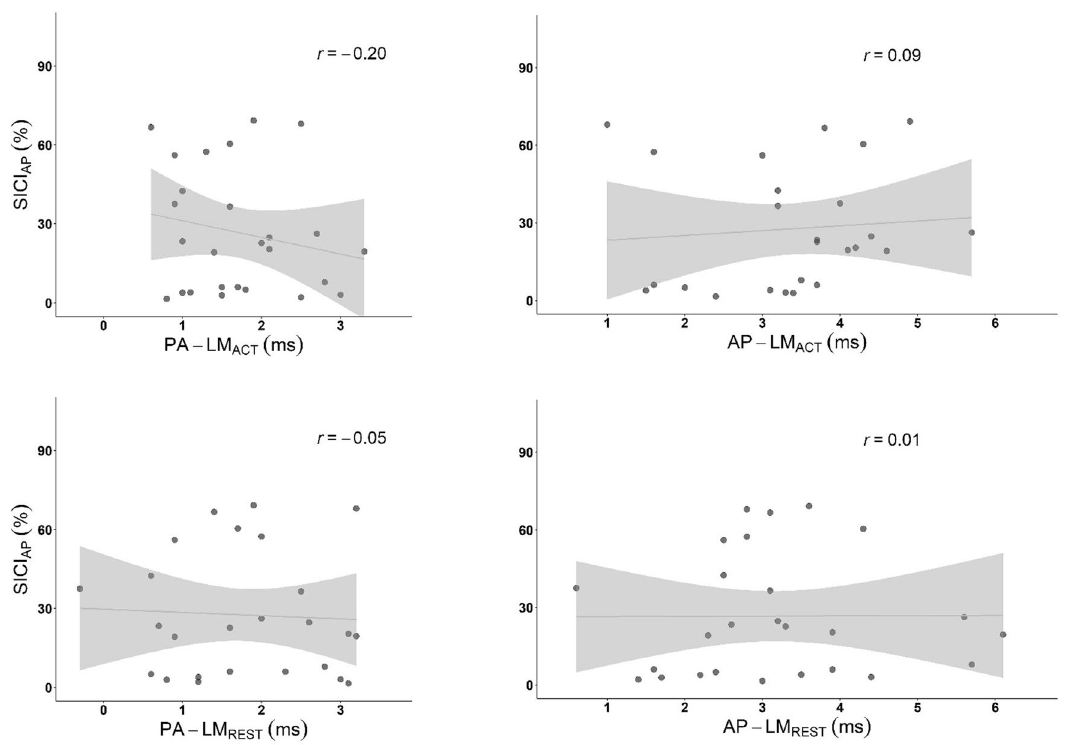
Figure 5. SICI AP and MEP Latency. SICI (%), Short-Interval Intracortical Inhibition 100% = no inhibition, < 100% = inhibition; Latency Difference (ms), Individual PA and AP latencies subtract active LM latency; PA, posterior-anterior; AP, anterior–posterior; LM, latero-medial; r , Pearson’s correlation